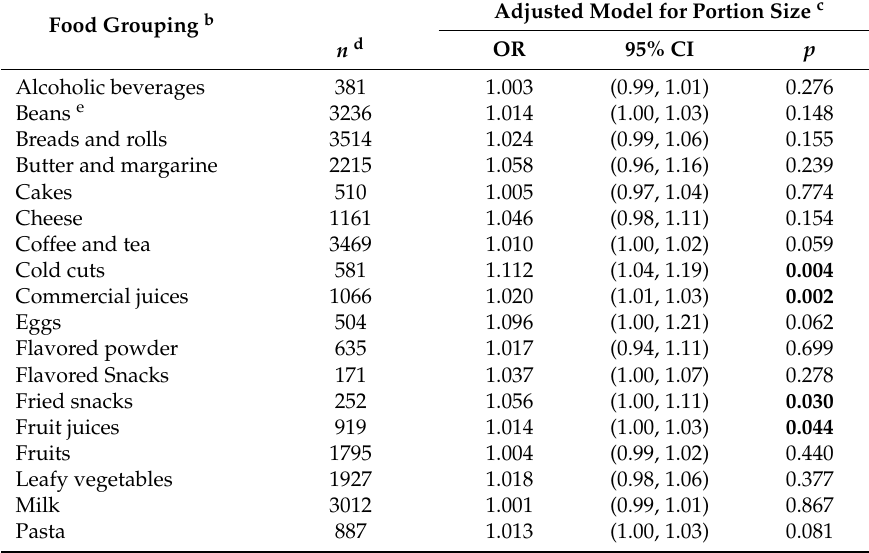
Table 3. Association of food groupings’ portion size for the total population in the Health Survey of S ã o Paulo with excess body weight a assessed using logistic regression